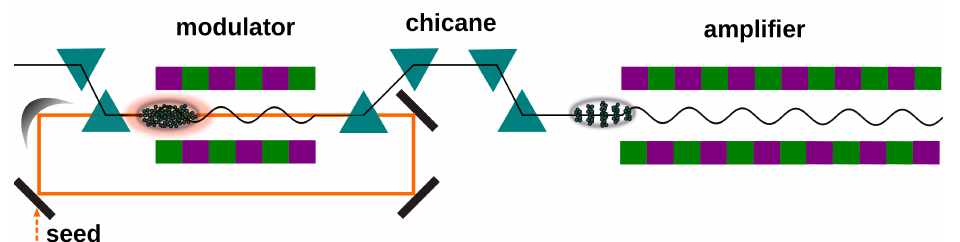
Figure 1. In an oscillator-based HGHG scheme, an optical cavity is added and encloses the modulator. The optical cavity acts as a feedback system which maintains the peak power of the stored radiation field and, under perfect synchronism, this field is used to seed consecutive electron bunches arriving from the linac upstream the cavity. Note that in reality, the optical cavity design will be more complex than this simplified